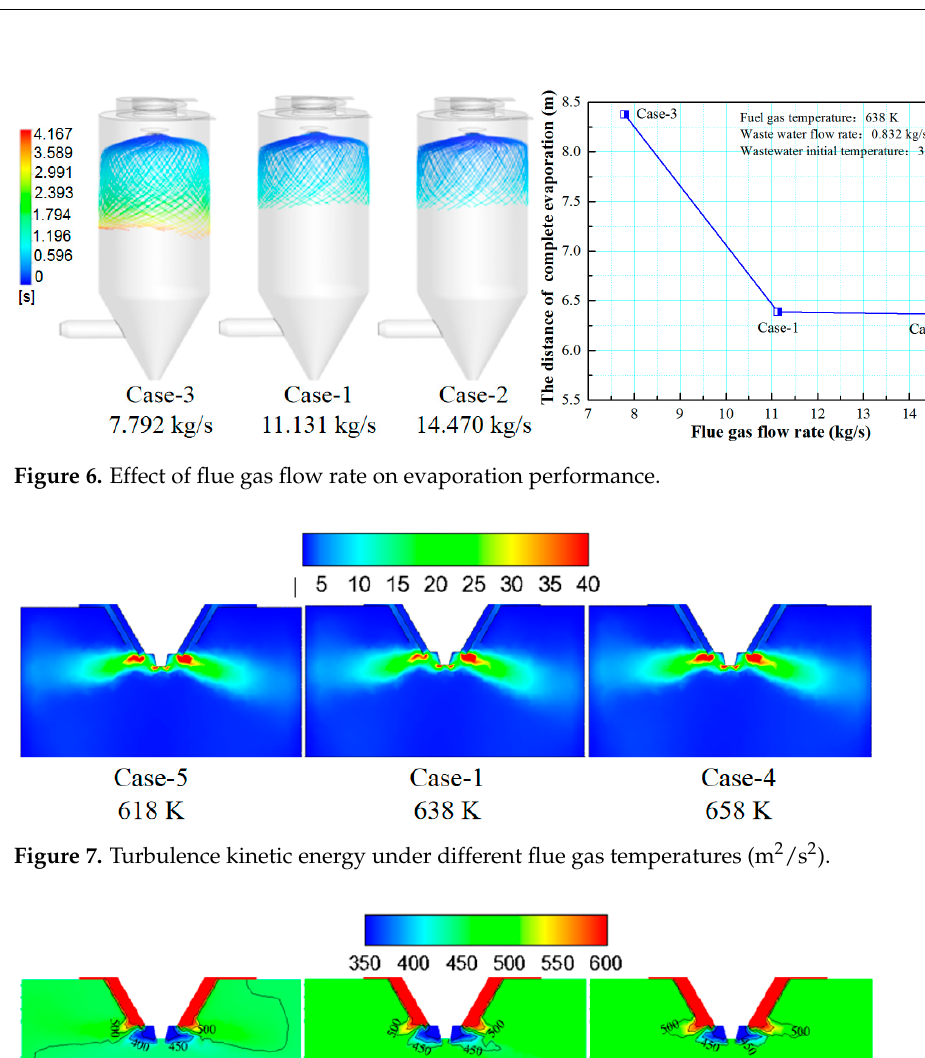
Figure 7. Turbulence kinetic energy under different flue gas temperatures (m 2 /s 2 ). Figure 8. Temperature under different flue gas temperatures (K). Figure 8. Temperature under different flue gas temperatures